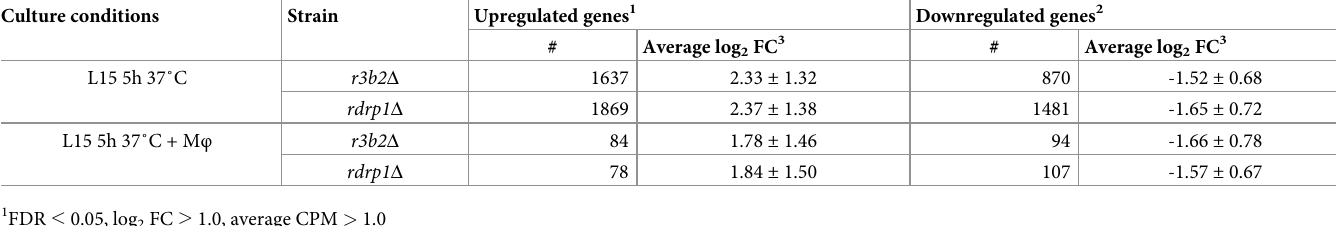
Table 1. Differentially expressed genes in NCRIP mutant strains compared with the wild-type strain. Culture